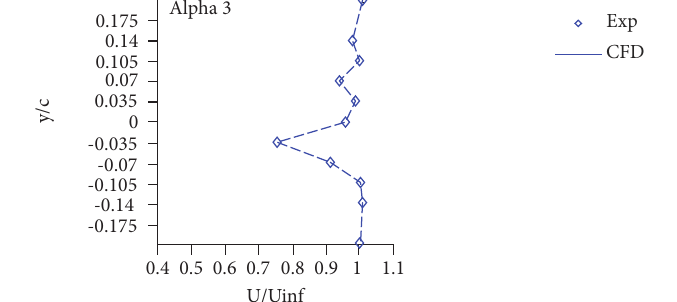
Figure 29. Streamwise velocity profile, pitch motion α (t) = 3 + 3 sin( w t), frequency = 3 Hz, Mach = 0.6.